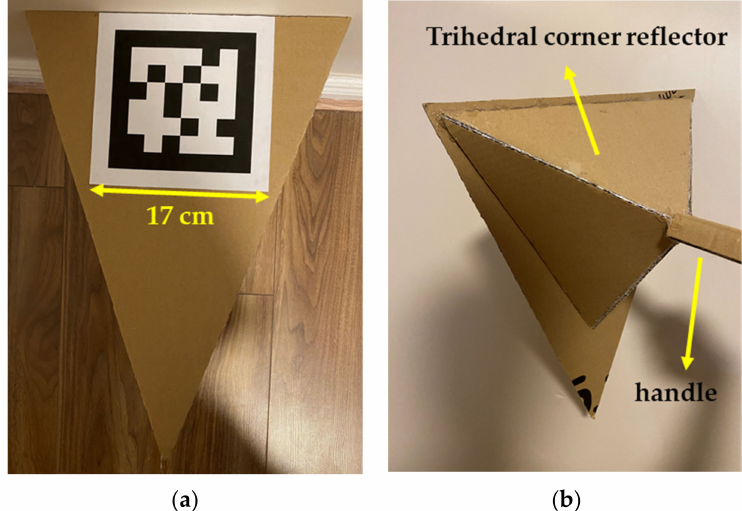
Figure 11. The proposed triangular calibration target design to spatial temporal calibrates the sensors (camera, radar, LiDAR). ( a ) Front view of the calibration board consists of a printed AprilTag marker with a size of approximately 17 cm in length. ( b ) The trihedral corner reflector is attached at the rear of the triangular board in which the inner sides are overlaid with aluminum foil. The calibration target in figure is constructed based on and reference [169–171] and through personal communication